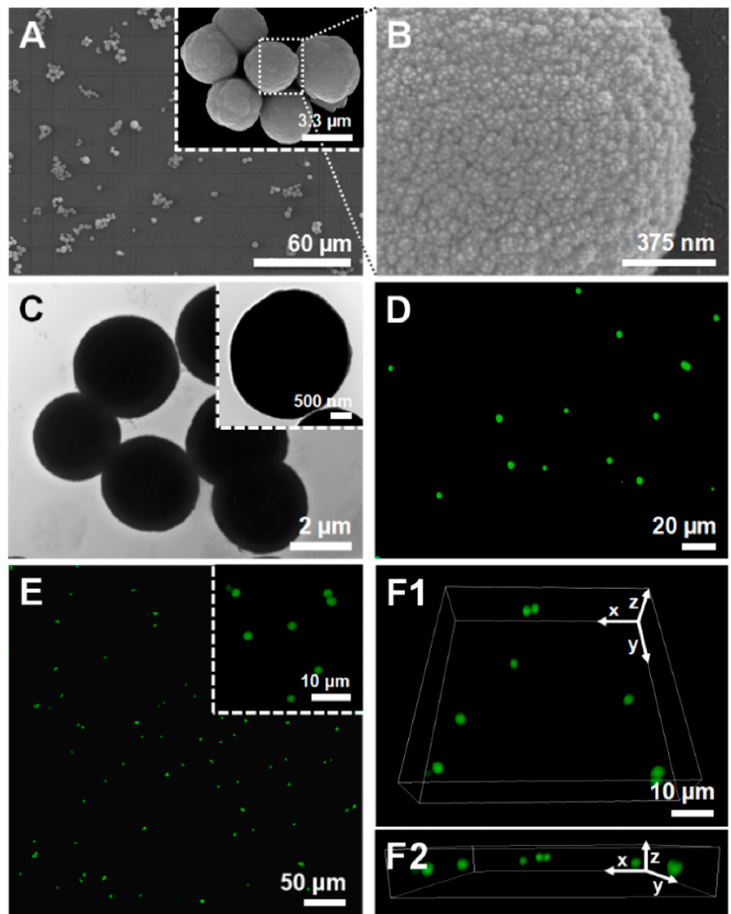
Figure 1. ( A , B ) SEM, ( C ) TEM, ( D ) FL microscopy and ( E , F ) CLSM micrographs of the